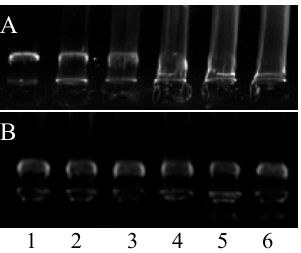
Figure 5. The agarose gel electrophoresis of bacterial DNA ( A ) and plasmid DNA ( B ). lane 1, the control; lanes 2–6, the samples treated with 0.25 × , 0.5 × , 1 × , 2 × MIC, and 4 × MIC essential oils, respectively.